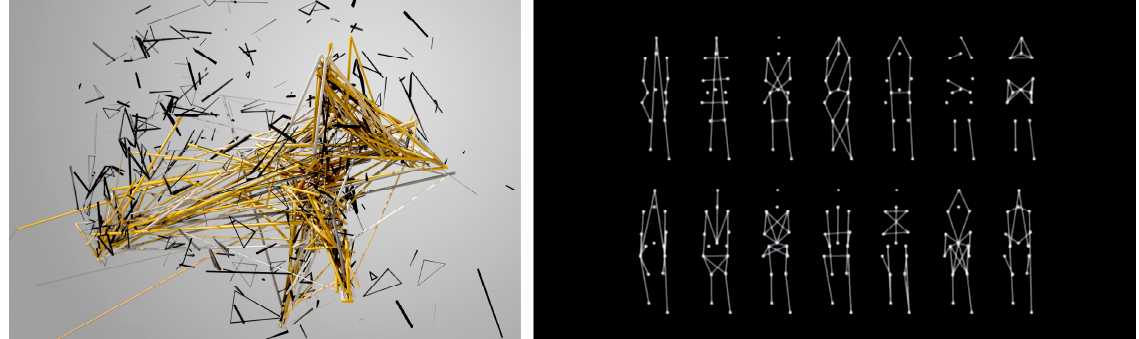
Figure 8. On the left , frame retrieved from the video made by Quayola and Memo Akten, Forms , 2012; on the right , frame retrieved from the video made by the EUPHRATES research group for the fashion designer Issey Miyake,